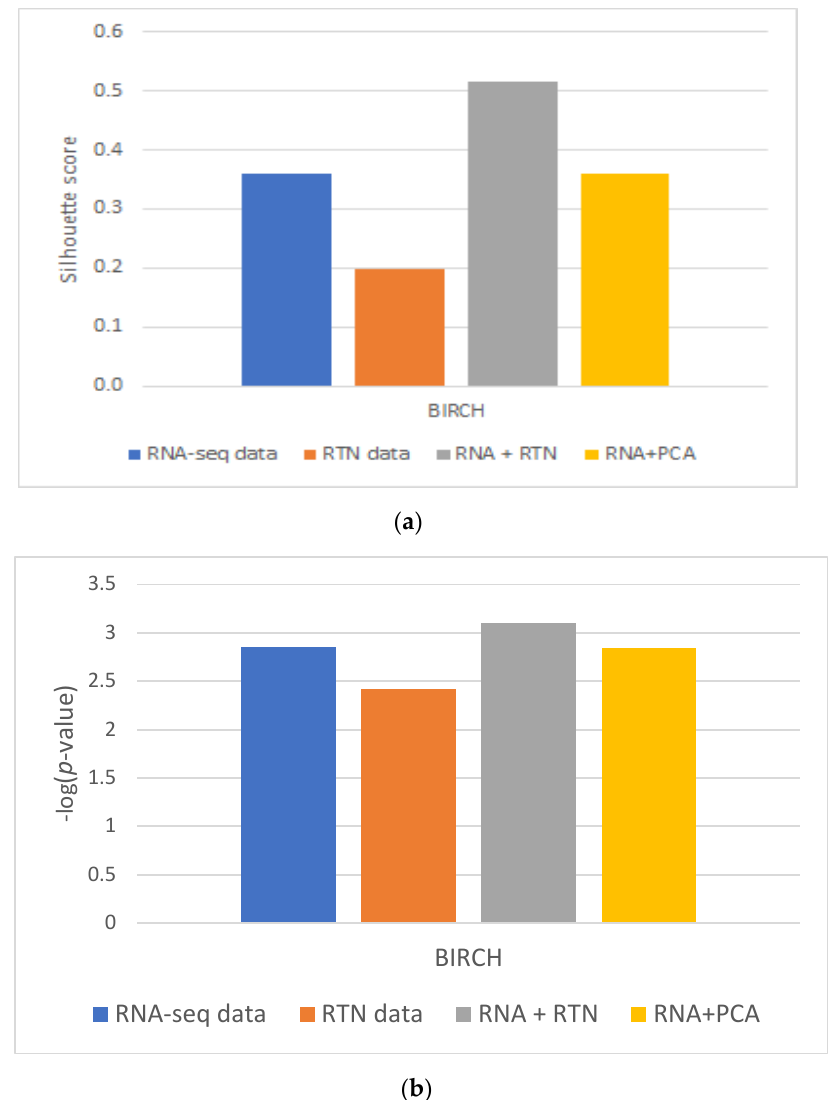
Figure 3. The impact of dimension reduction with PCA on cluster quality. The RNA-seq + RTN comparison data are compared to RNA with PCA. ( a ) Comparison of the Silhouette Coefficient. ( b ) Comparison of survival difference between patients assigned to each of the groups created with each data type. Table 2. The FAB division of patients in the 2 groups. The BIRCH algorithm was used to divide the patients into 2 groups (see text), and the number of patients with each FAB type is shown. The likelihood of finding all patients in group 1 in M3 of the RNA + RTN analysis was calculated ( p = 0.00371 for N ewton’s binomial).